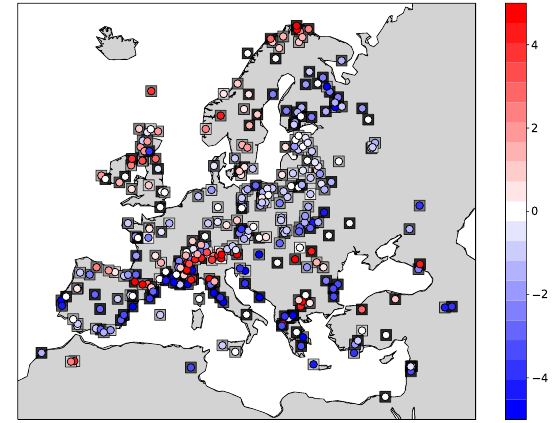
Figure 16. Weighted arithmetic mean using time distances: anoma- lies (6KBP–0.2KBP) of assimilated observations (circles) super- posed on their standard errors (squares) with values in K. Color bar of the standard errors as in Fig. 15a.